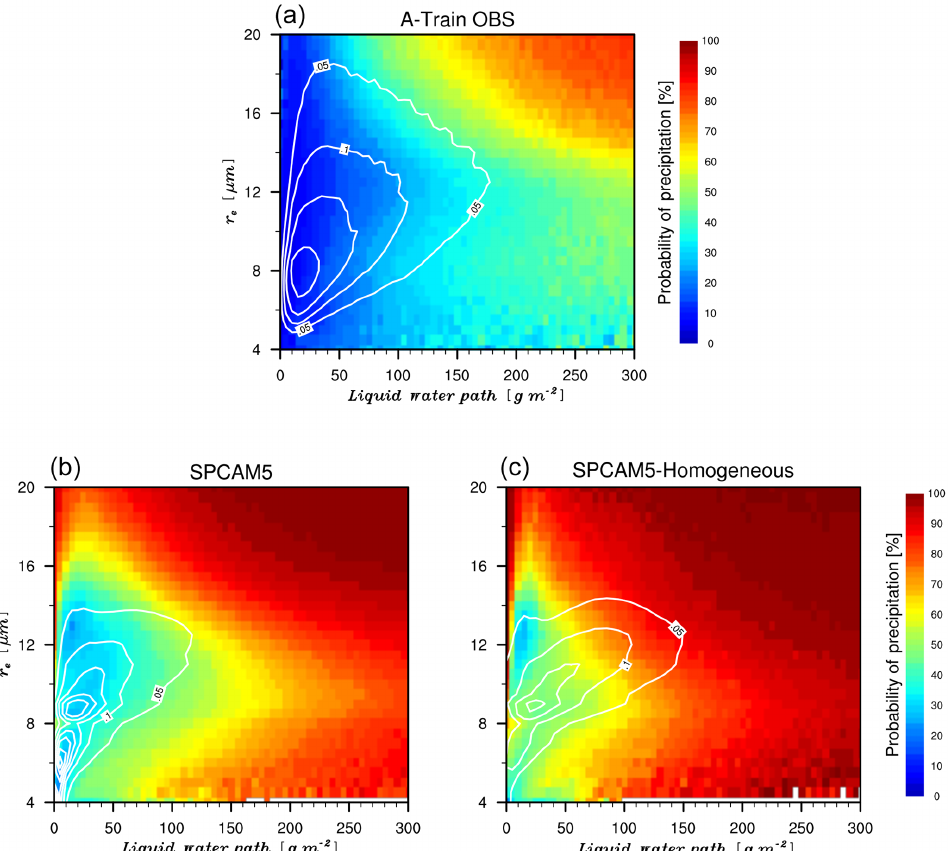
Figure 6. POP (drizzle or rain) of liquid clouds at each LWP and liquid cloud effective radius in the satellite observations (a) , the SPCAM5 COSP simulation (b) , and the SPCAM5-Homogeneous COSP simulation (c) . The white solid contours are joint PDF of LWP and liquid cloud effective radius. Units of POP and PDF are